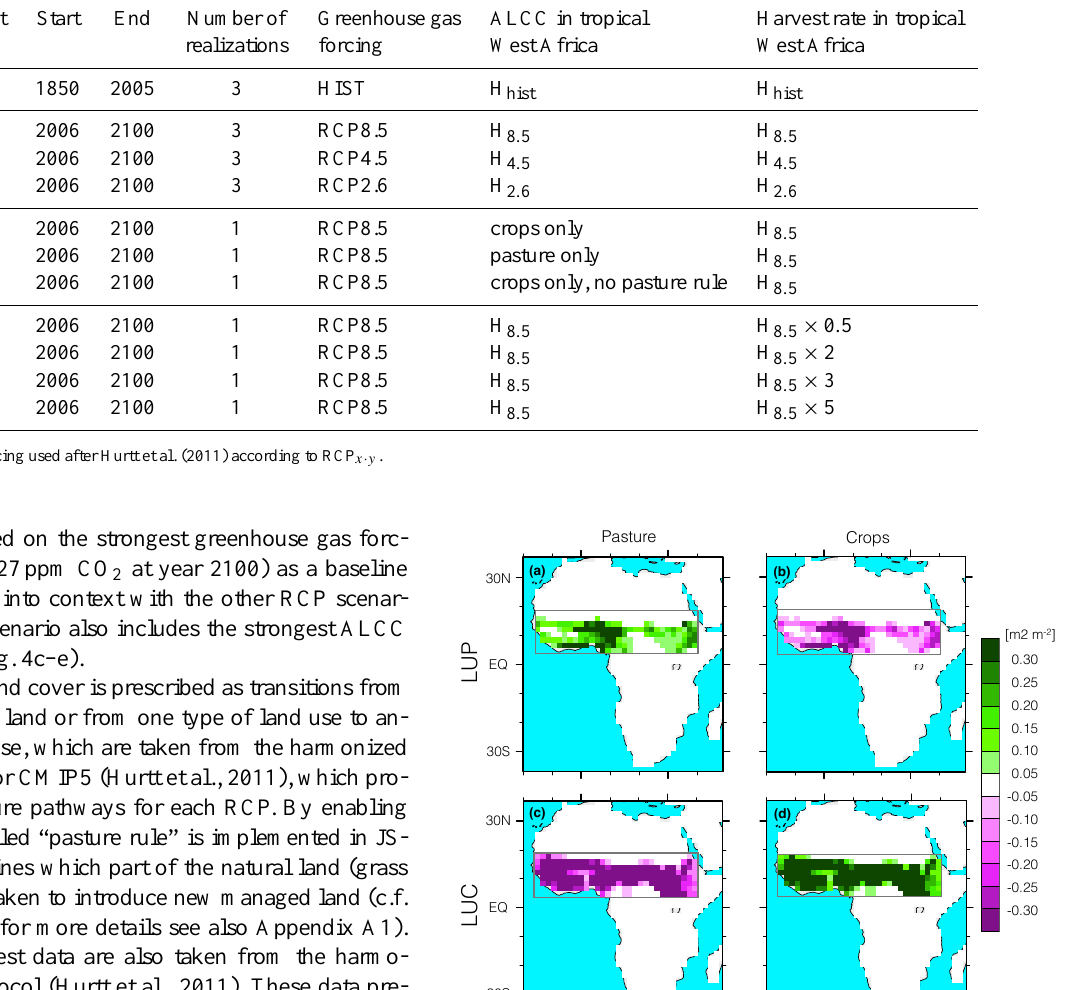
Table 1. List of experiments and their basic set-up with respect to prescribed anthropogenic land cover change (ALCC), harvest rate, and prescribed greenhouse gas forcing.